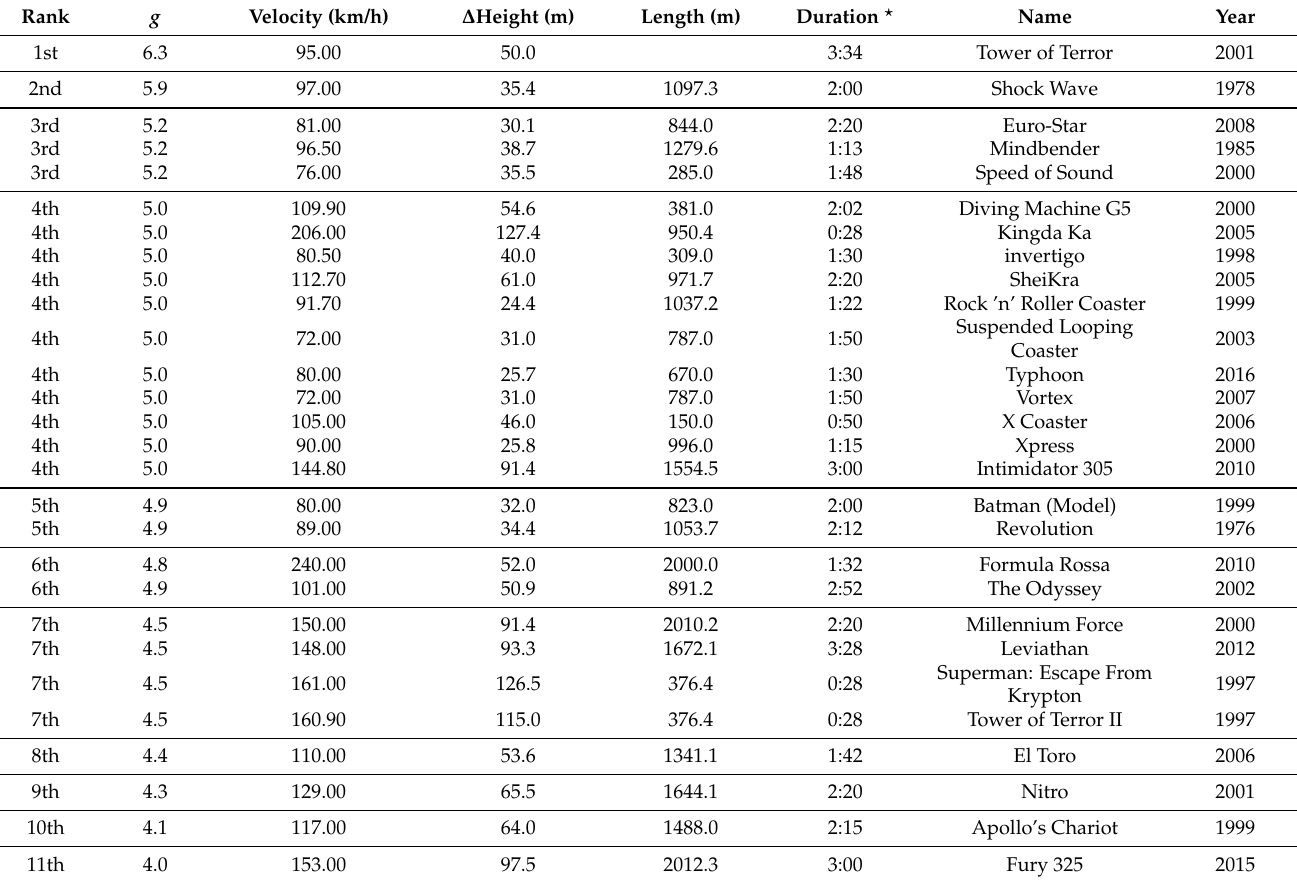
Table 2. The top 11th high G-force roller